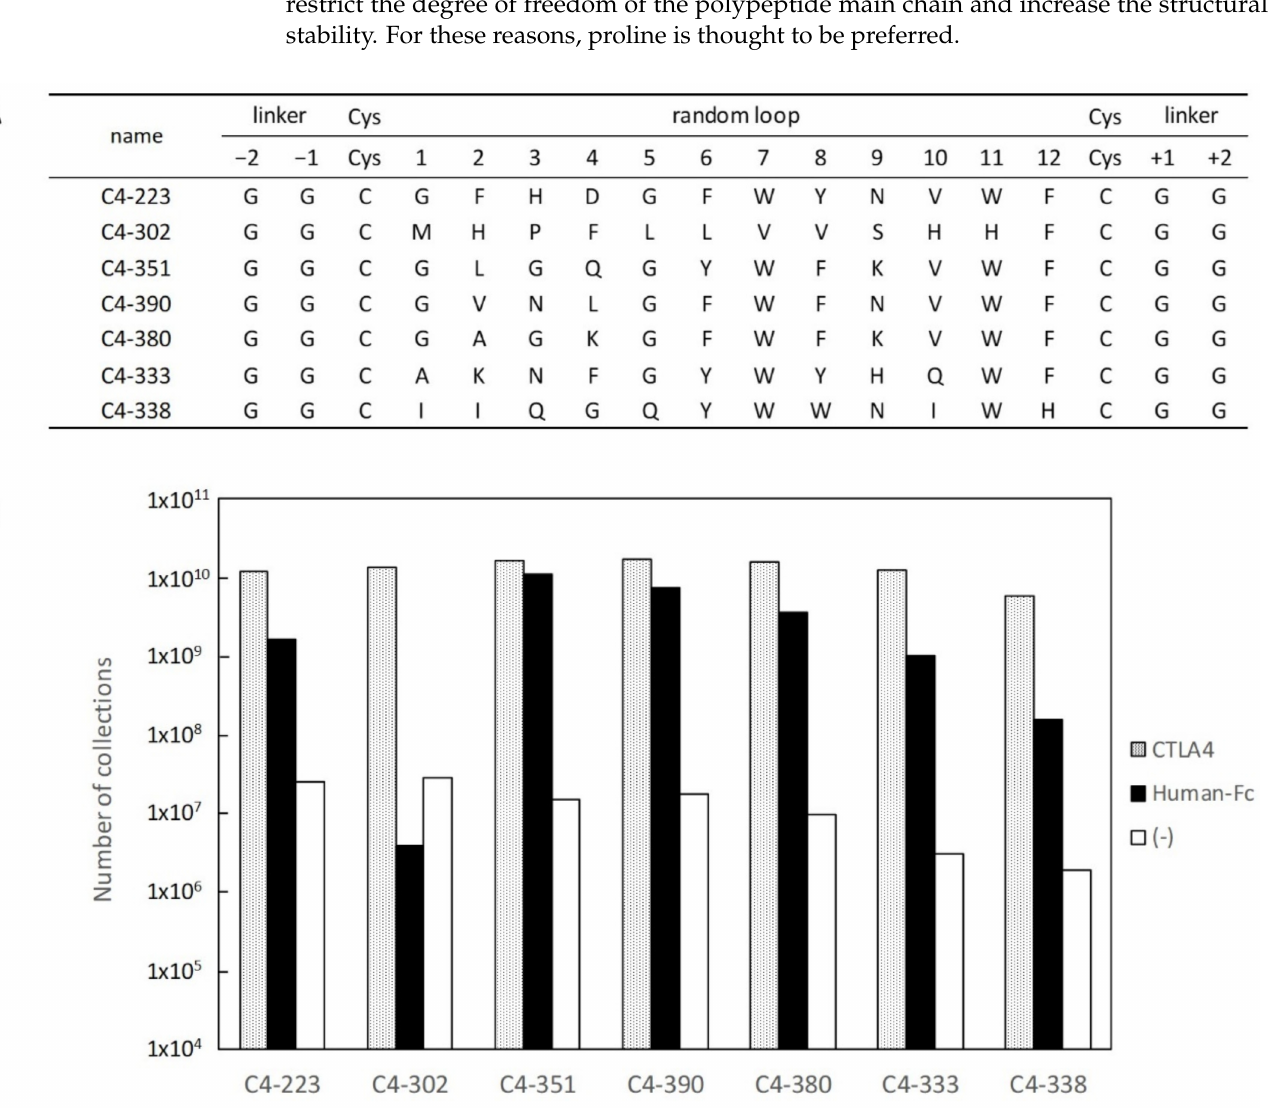
Figure 2. Sequences of selected clones and their binding specificity. ( A ) Selected amino acid sequences of clones from PURE frex ® RD for CTLA-4-Fc. ( B ) Binding specificity of clones in ( A ) was evaluated as follows: mRNA–ribosome–peptide complex of each clone was reacted with each biotinylated protein (CTLA-4-Fc, dotted box; Human-Fc, black box; (-), white box) immobilized on streptavidin magnetic beads. Number of isolated mRNAs was determined by